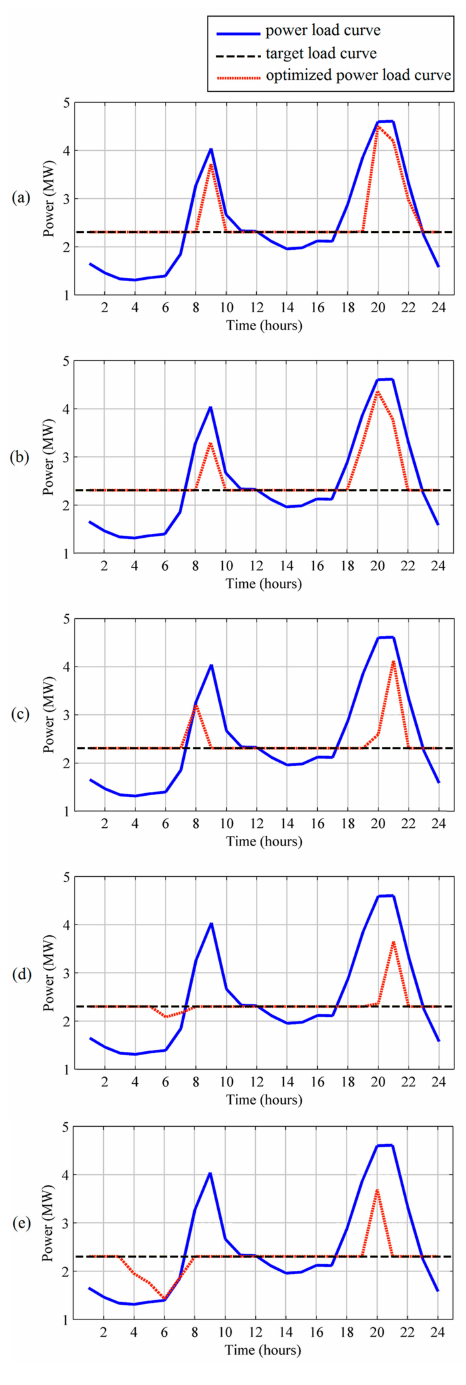
Figure 6. Optimized power load curves with 50% TLC pct and SOC i,ave of ( a ) 40%, ( b ) 50%, ( c ) 60%, ( d ) 70% and ( e )